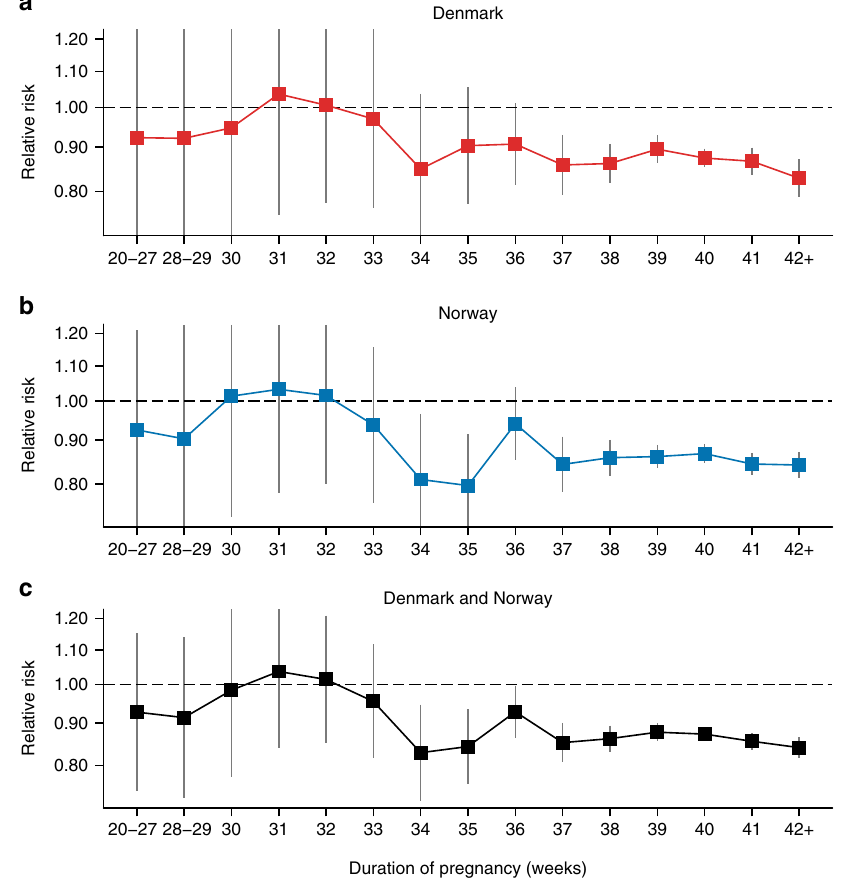
Fig. 2 Long-term relative risk of breast cancer after an early age childbirth compared with one childbirth less, according to duration of pregnancy. a Denmark, b Norway, and c combined. Error bars indicate 95% con fi dence intervals